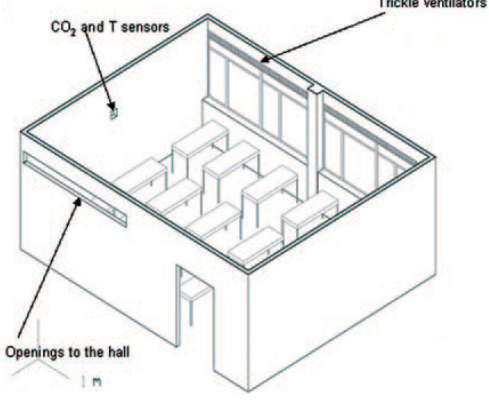
Figure 24. Typical classroom [12].